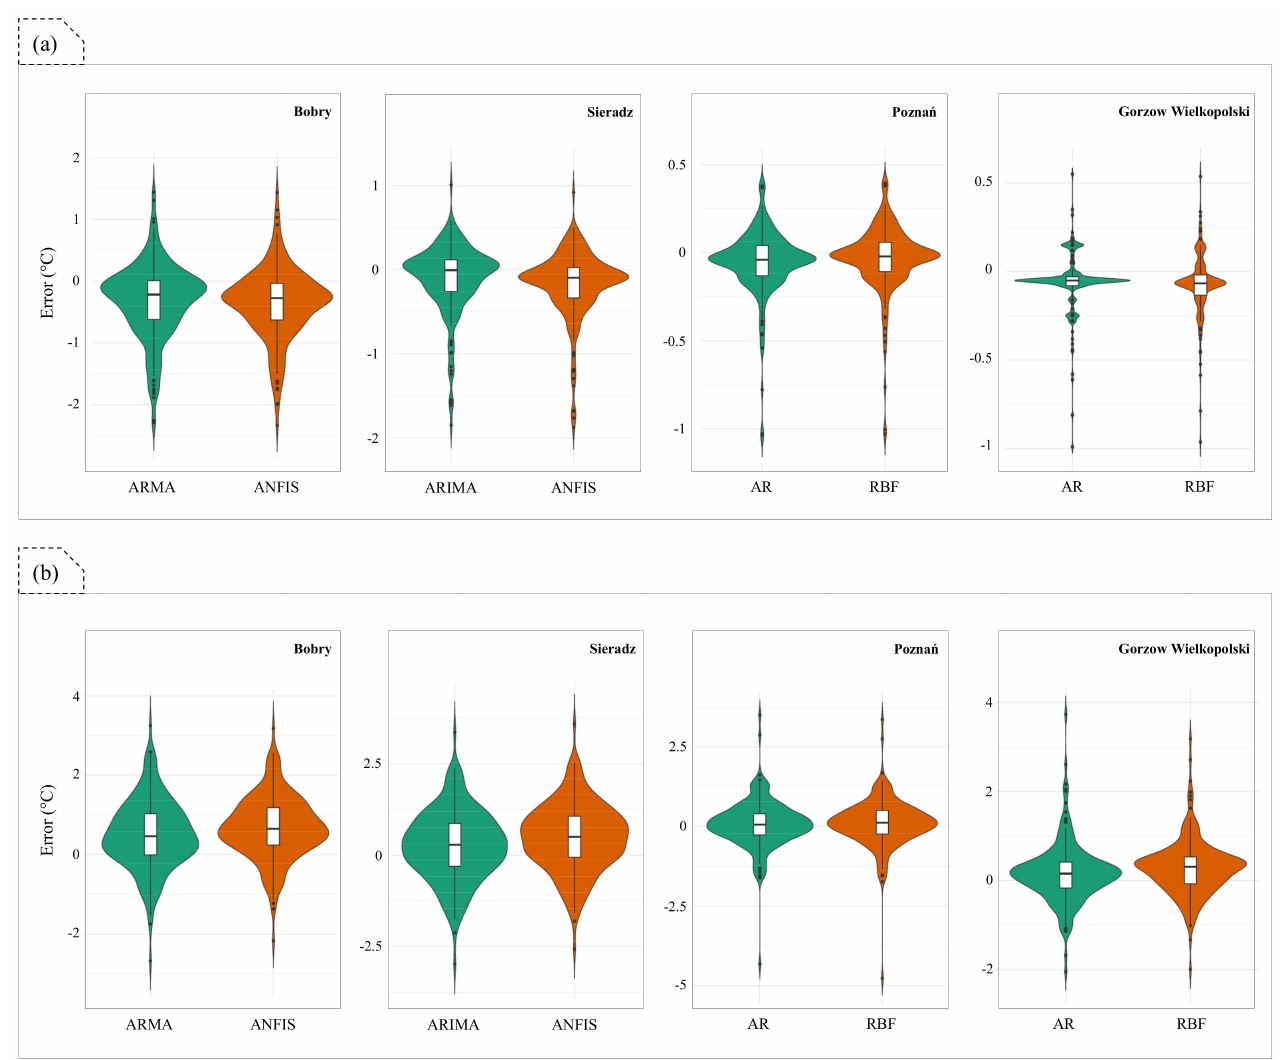
Figure 8. Violin plots to evaluate the error distributions in the lower ( a ) and upper deciles ( b ) of